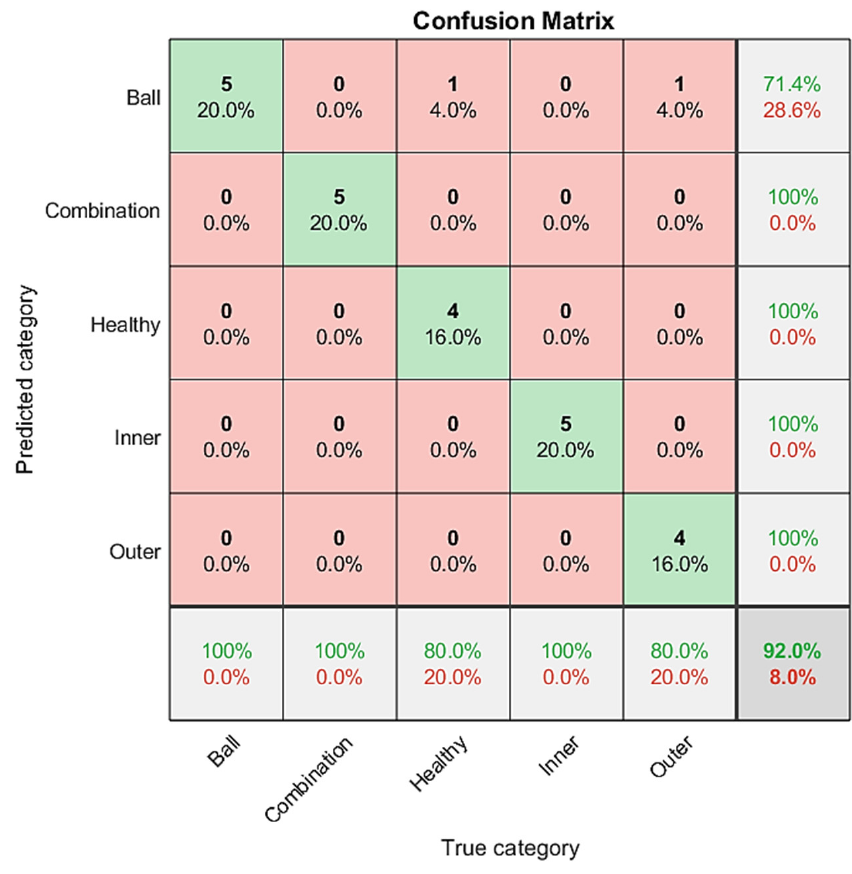
Figure 16. DenseNet classification results in confusion matrix; the accuracy rate is 92%.